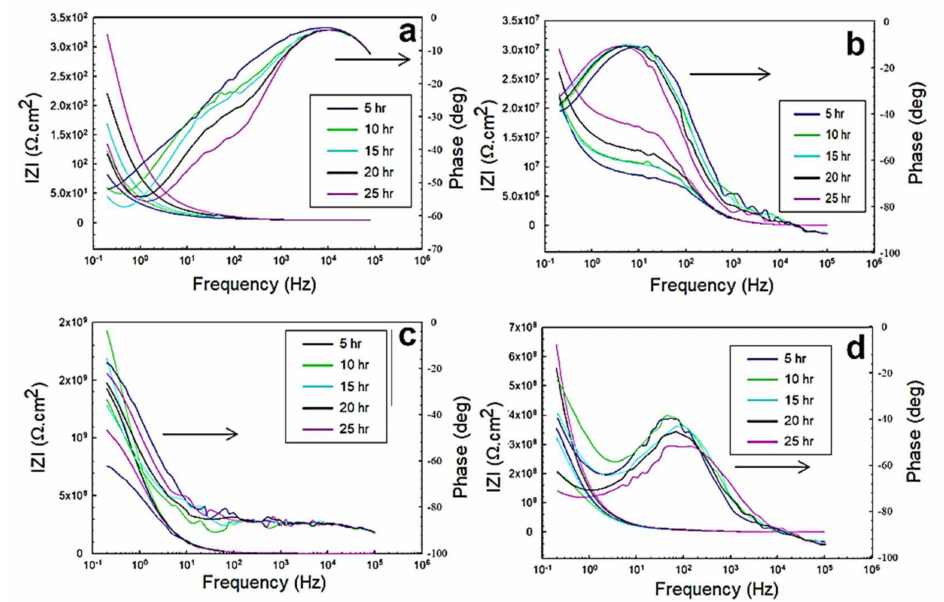
Figure 9. EIS Bode plots of the 0.5 M NaCl solution for: ( a ) exposed steel, ( b ) glass/epoxy, ( c ) Kevlar/epoxy, ( d ) epoxy